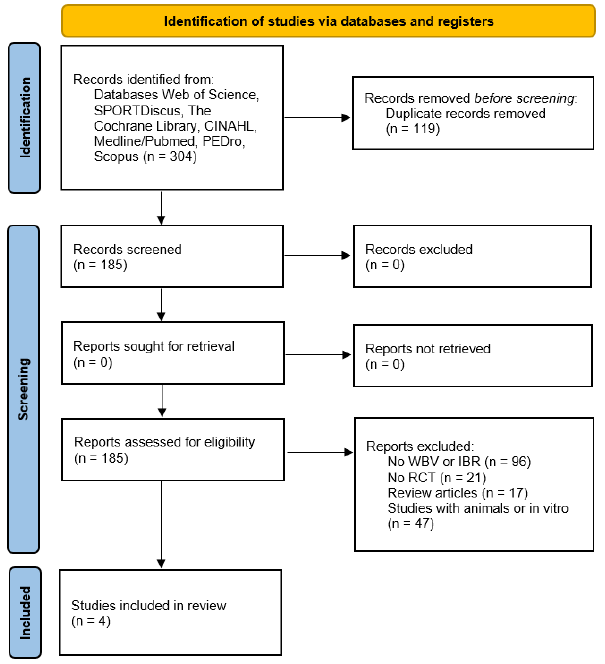
Figure 1. The PRISMA flowchart.